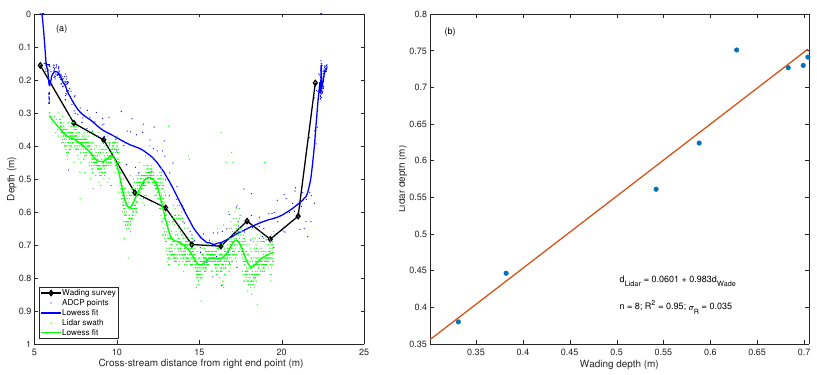
Figure 6. ( a ) Depth comparison between lidar, wading, and ADCP measurements along cross section 1. ( b ) Accuracy assessment of lidar-derived depths via linear